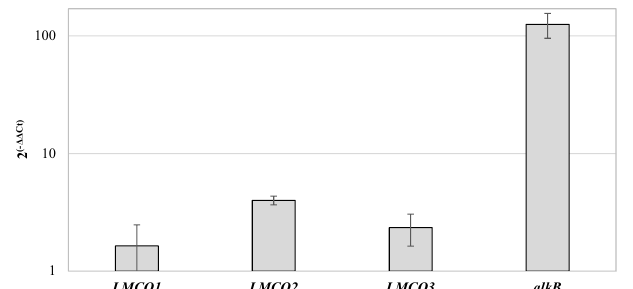
Figure 5. Expression levels of R7 selected genes for RT-qPCR analysis. The selected genes are LMCO1 , LMCO2 , LMCO3 , and alkB encoding laccase-like multicopper oxidase 1, 2 and 3 and alkane monooxygenase, respectively.